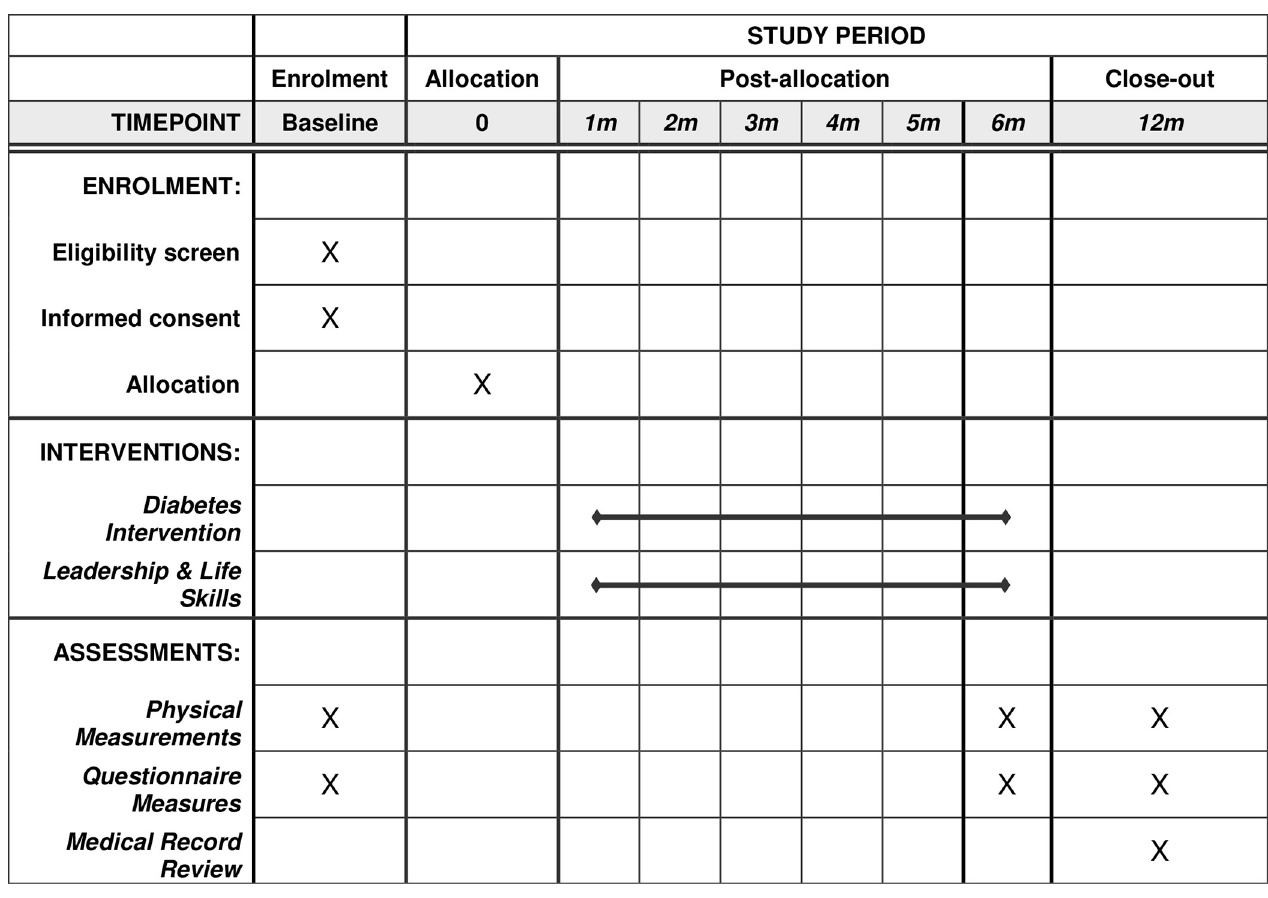
Fig 1. Schedule of enrolment, intervention, and